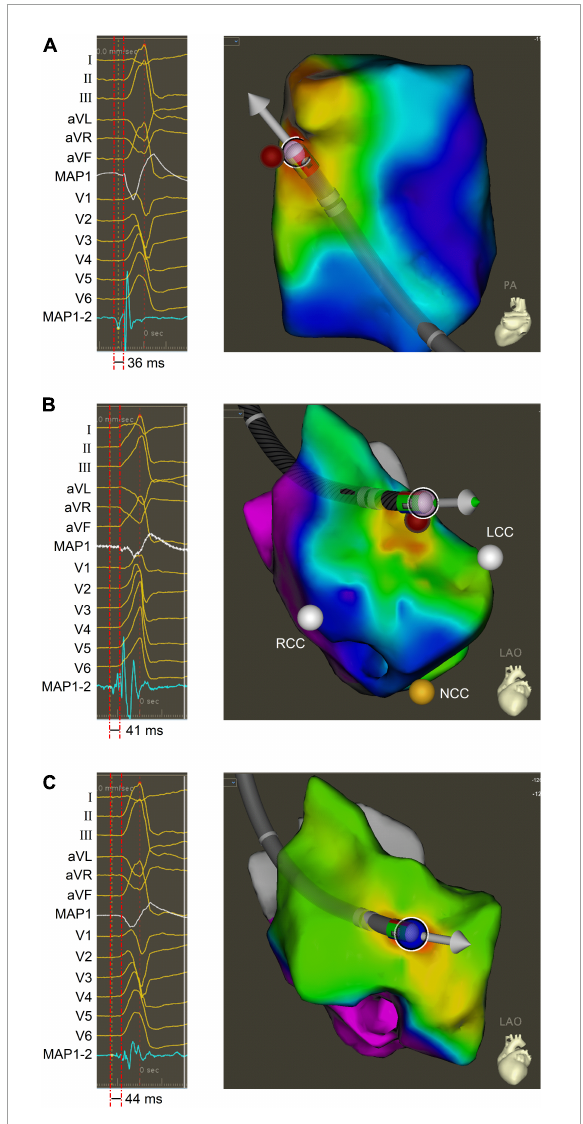
FIGURE2 Activation mapping of PVCs. (A) Intracardiac ECG ( left panel) and electro-anatomic map ( right panel) obtained during activation mapping of PVC-1 in the anterior septum of RVOT. (B) Intracardiac ECG ( left panel) and electro-anatomic map ( right panel) obtained during activation mapping of PVC-2 near the LCC. (C) Intracardiac ECG ( left panel) and electro-anatomic map ( right panel) obtained during activation mapping of PVC-1 at the L-RCC. The bipolar ECG exhibited the LVP preceding the QRS onset, and electro-anatomic map showed ablation site in different electro-anatomic mapping areas. ECG, electrocardiogram; LCC, left coronary cusp; L-RCC, the left-right coronary cusp commissure; LVP, local voltage potential; MAP1, unipolar ECG; MAP1-2, bipolar ECG; RCC, right coronary cusp; PVC, premature ventricular contraction; RVOT, right ventricular outflow